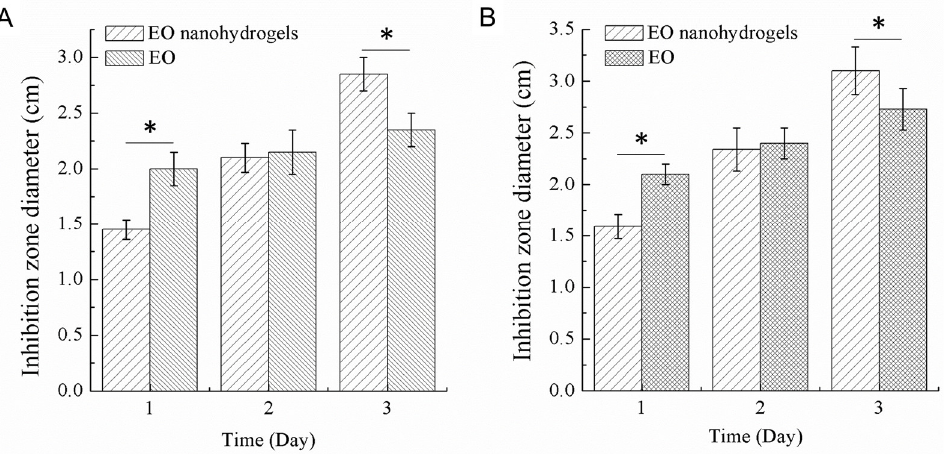
Figure 7. Antibacterial activities of QEO nanohydrogels and free QEO against S. aureus ( A ) and E. coli ( B ). An asterisk (*) indicates significant difference with p < 0.05.